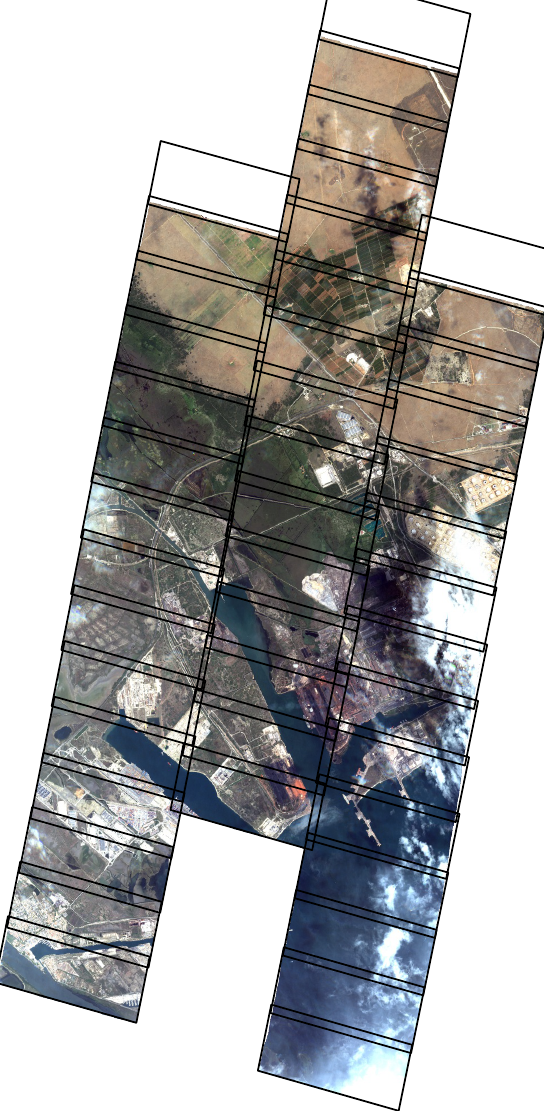
Figure 3: Fos sur Mer industrial zone as seen by Skysat-1. The bounding boxes show the individual frames after coregistration and multi-image